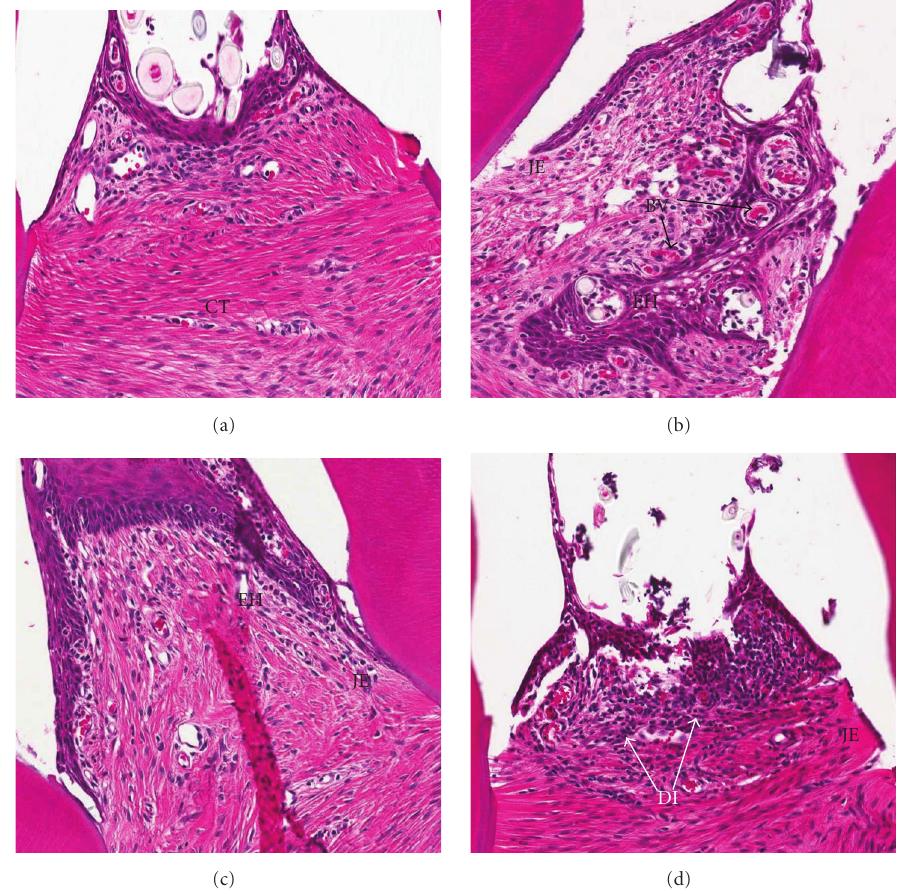
Figure 4: Representative sections from histopathology of periodontal tissue. Comparative maxillary histology (hematoxylin and eosin) of alveolar bone sections from maxilla of rat infected with P. gingivalis and/or T. denticola at 12 weeks. (a) from sham-infected control rat displaying minimal inflammation, lack of migration of junctional epithelium (JE) and minimal inflammation in the connective tissue (CT); (b) from the P. gingivalis infected rat showing prominent epithelium hyperplasia (EH), migration of JE and increase in number of blood vessels (BV) (indicated by black arrows); (c) from the T. denticola infected rat also exhibits migration of JE and EH; and (d) from the mixed infection with P. gingivalis + T. denticola infected rat demonstrates dense inflammation (DI) (indicated by white arrows) along with migration of JE. JE indicates junctional epithelium, CT connective tissue, EH epithelial hyperplasia, BV blood vessels, DI dense inflammation. All images at 20 ×